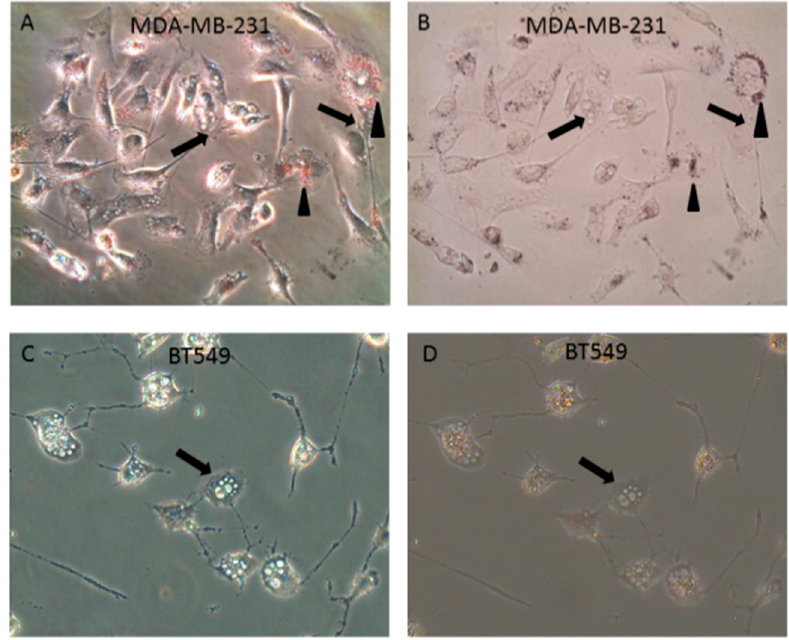
Figure 3. LT-IIc-induced vacuolation is not due to intracellular lipid accumulation. ( A ) Oil Red O staining revealed perinuclear pool of small lipid droplets (arrowheads) in all MDA-MB-231 cells treated with 1 µg/mL LT-IIc for 24 h, viewed under phase contrast ( A ) or bright field, after staining with Oil Red O ( B ). This small perinuclear lipid pool was independent of the large vacuoles (arrows). BT549 treated with 1 µg/mL LT-IIc lacked perinuclear lipid droplets seen in MDA-MB-231 cells. Large intracellular vacuoles were Oil Red O negative (arrows). ( C , D ) BT549 cells lacked perinuclear lipid droplets seen in MDA-MB-231 cells. Large intracellular vacuoles were oil red O negative. All images were obtained using 40× objective magnification.